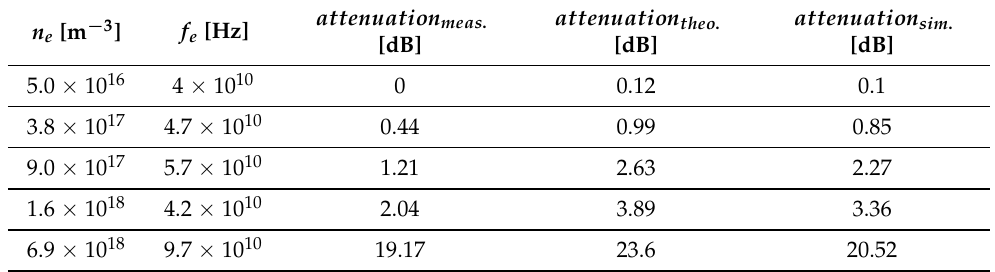
Table 4. The comparison of the transmission function at 100 GHz.